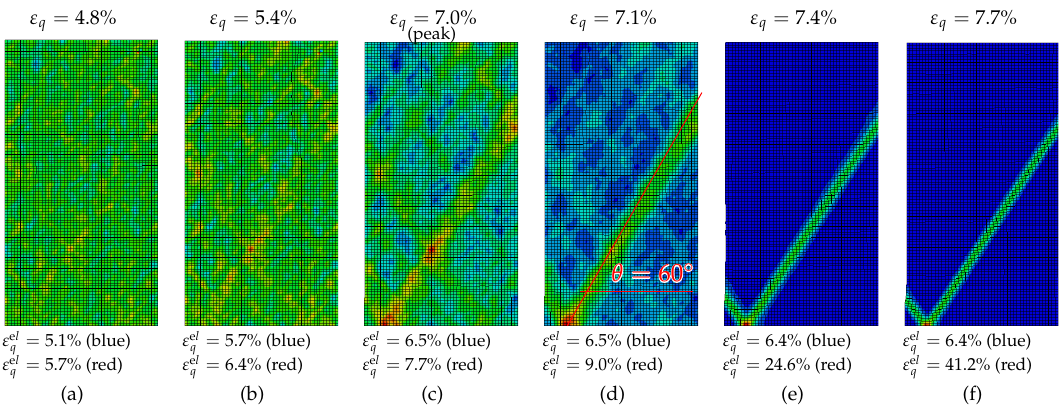
Figure 9. OCR = 54: Shear band development displayed with deviatoric strain in each element ε el q at different global deviatoric strain ε q , peak in q is at ε q = 7.0%. ( a – c ) show pre-peak pattern of shear bands, ( d ) peak and ( e , f ) post-peak pattern of shear